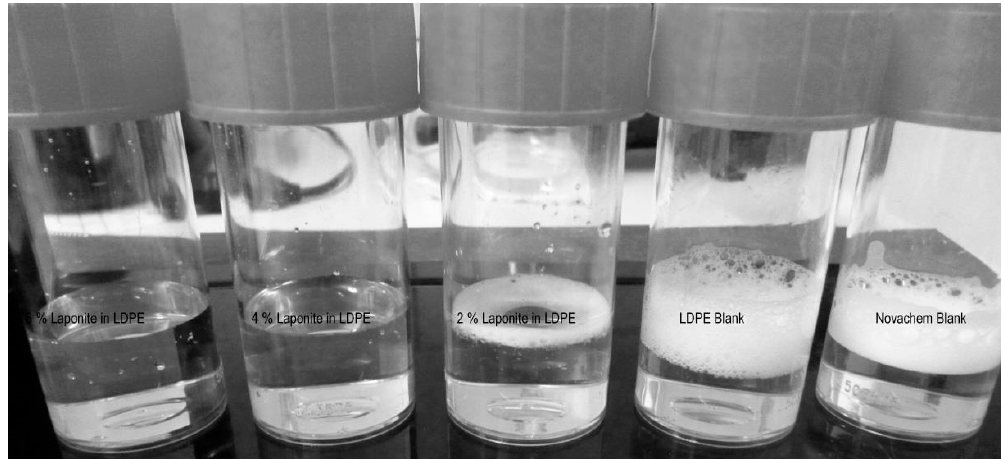
Figure 6. Migration samples after they were shaken. From left to right: 6% Laponite in LDPE, 4% Laponite in LDPE, 2% Laponite in LDPE, LDPE blank and the surfactant blank used as food simulant for all migration samples.